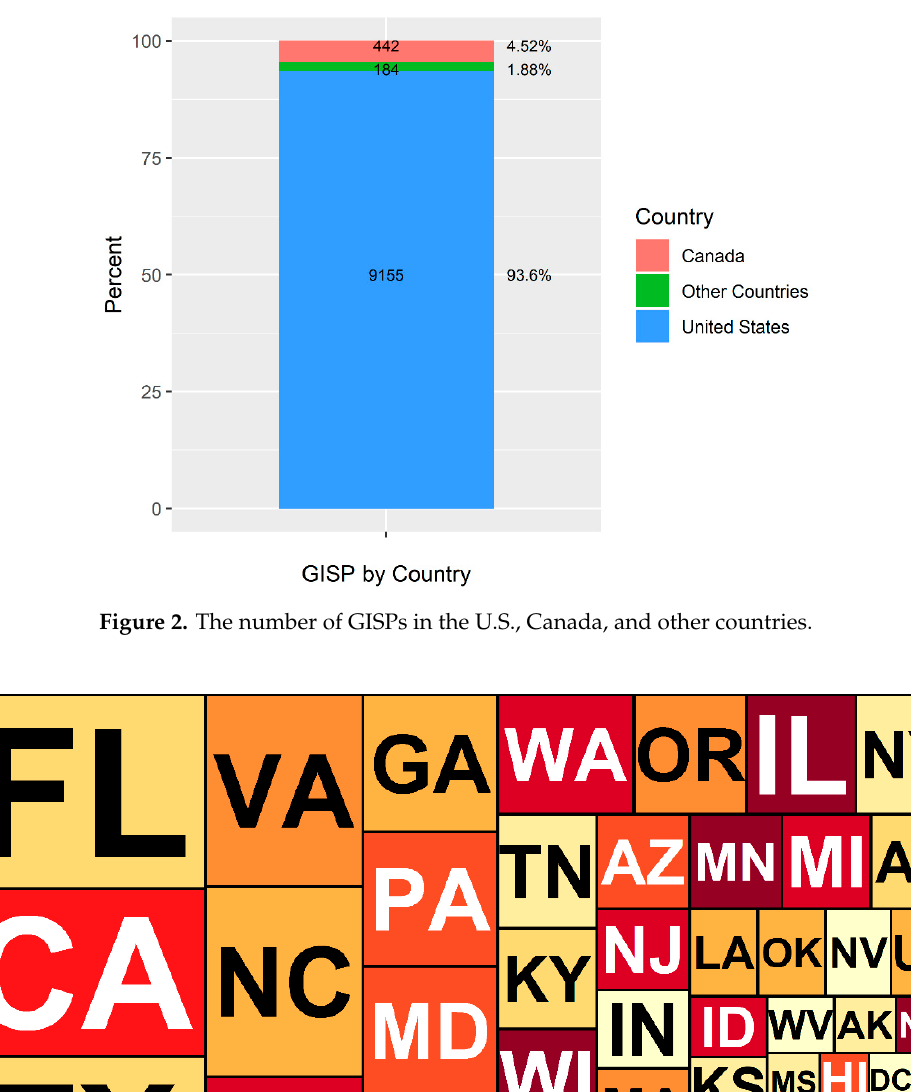
ISPRS Int. J. Geo-Inf. 2018 , 7 , x FOR PEER REVIEW